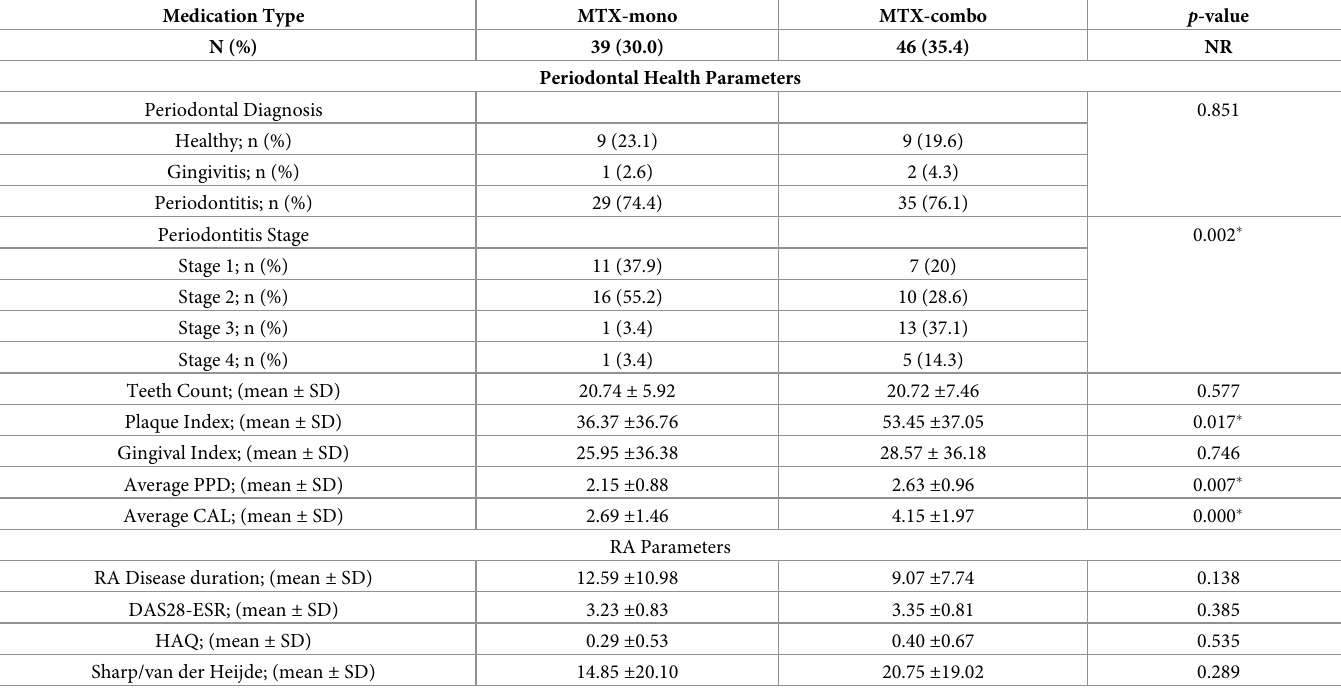
Table 6. Periodontal health parameters and RA parameters according to the methotrexate monotherapy or methotrexate in combination with other DMARDs. Medication